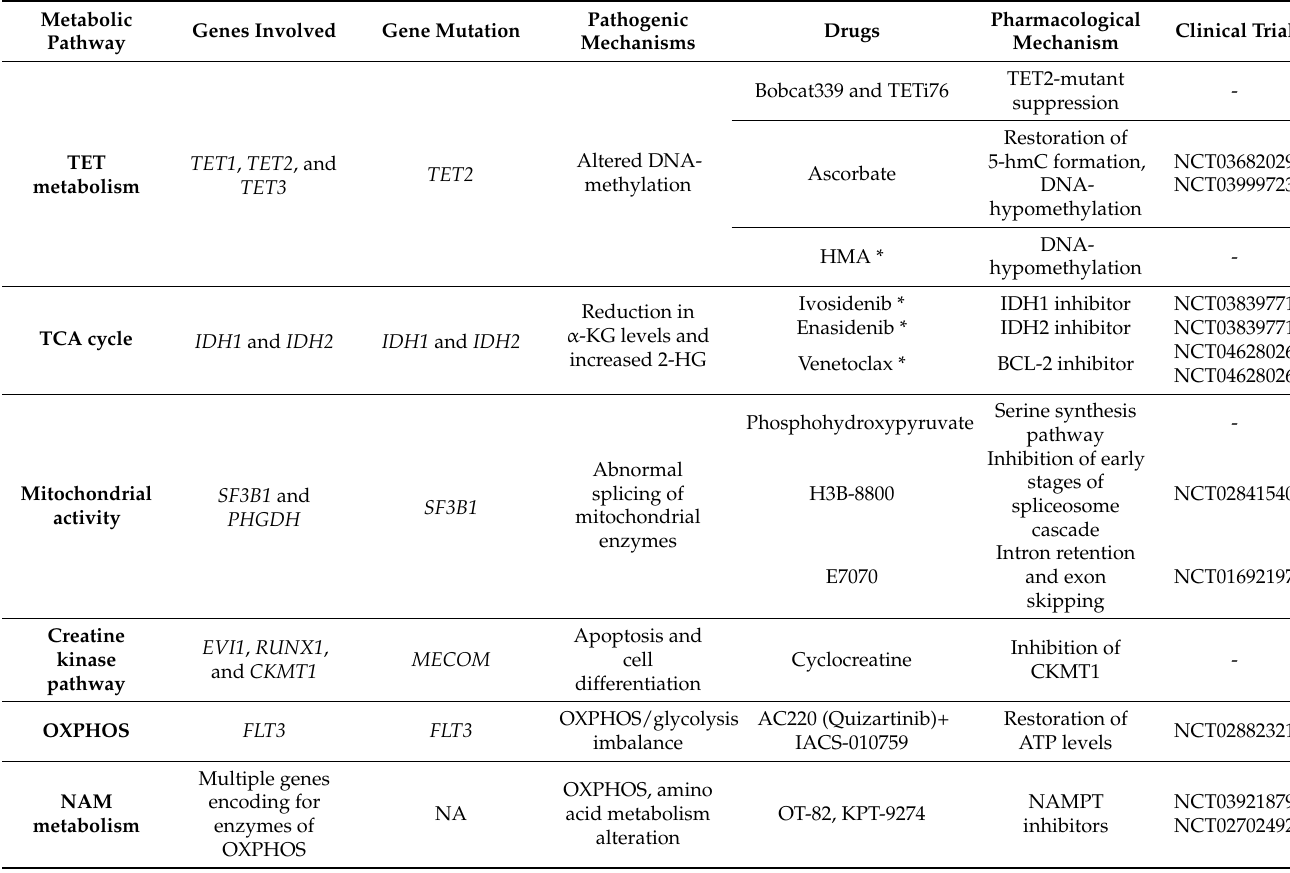
Table 1. Therapeutic strategies, targets, and mechanisms in myeloid